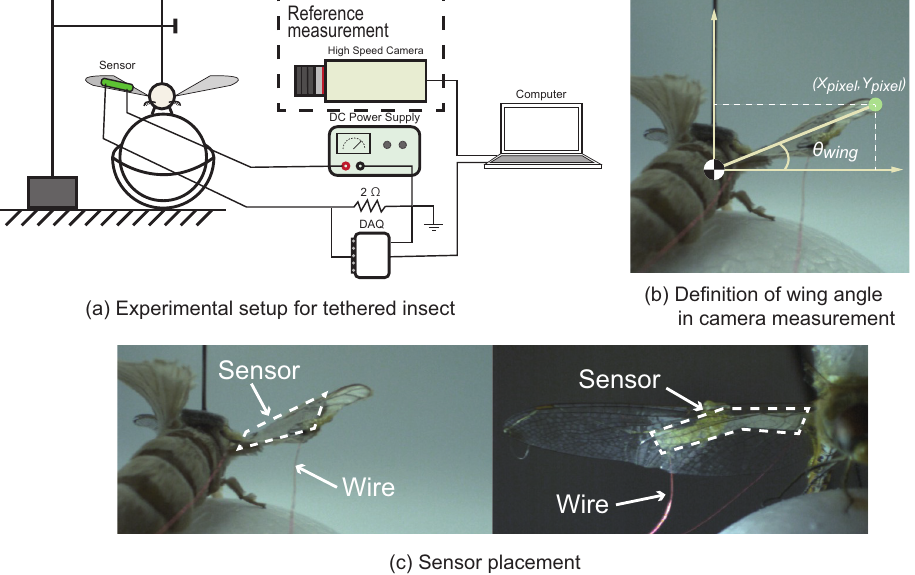
Figure 4. Experimental setup of tethered insects. A schematic of the testing environment is shown in ( a ), and the wing angle used for the experiment is shown in ( b ). A typical image of the sensor placement on a silk moth and a dragonfly is shown in ( c ) (see Supplementary Material Video